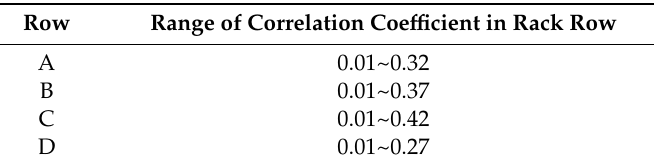
Figure 8. Power consumption of B1 rack. Table 3. Range of correlation coefficient in rack row.